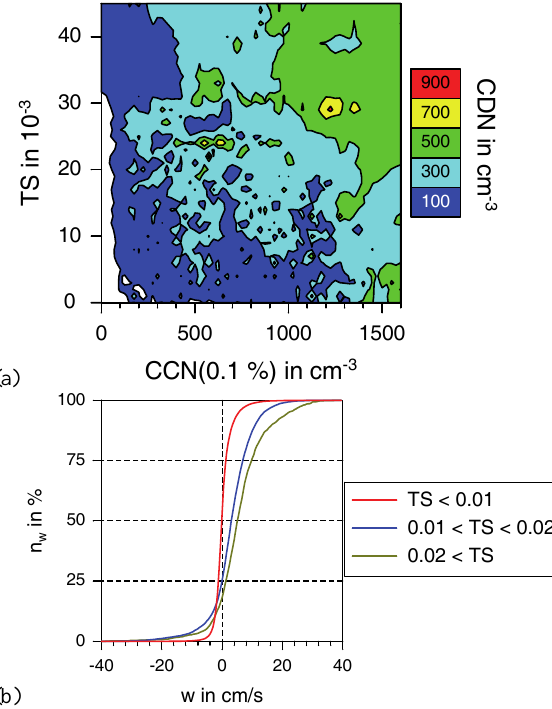
Fig. 5. (a) Dependence of CDN concentrations on terrain slope pa- rameter TS and CCN (0.1%) concentration for 18–20 August 2005 (b) Cumulative percentage contribution n w of the grid-scale in- cloud vertical velocity for different values of TS for 18–20 Au- gust 2005. CDN and CCN concentrations as well as the in-cloud vertical velocity are vertical averages for 0 to 1500ma.s.l. (Simu- lation